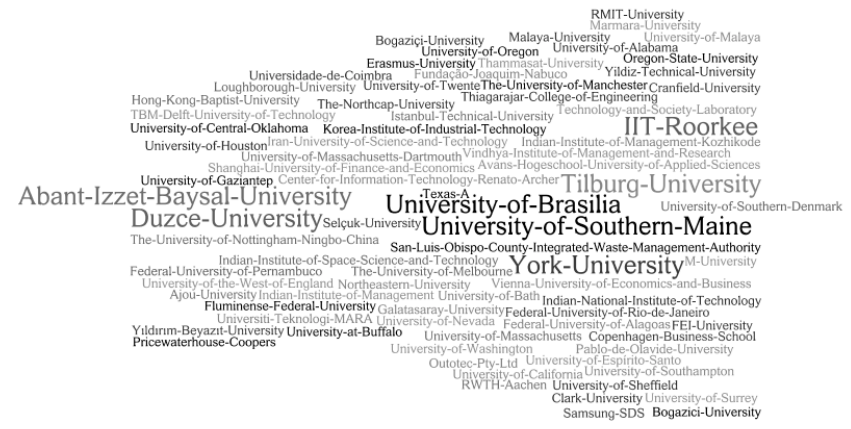
Figure 3. Universities most productive (considering corresponding authors).